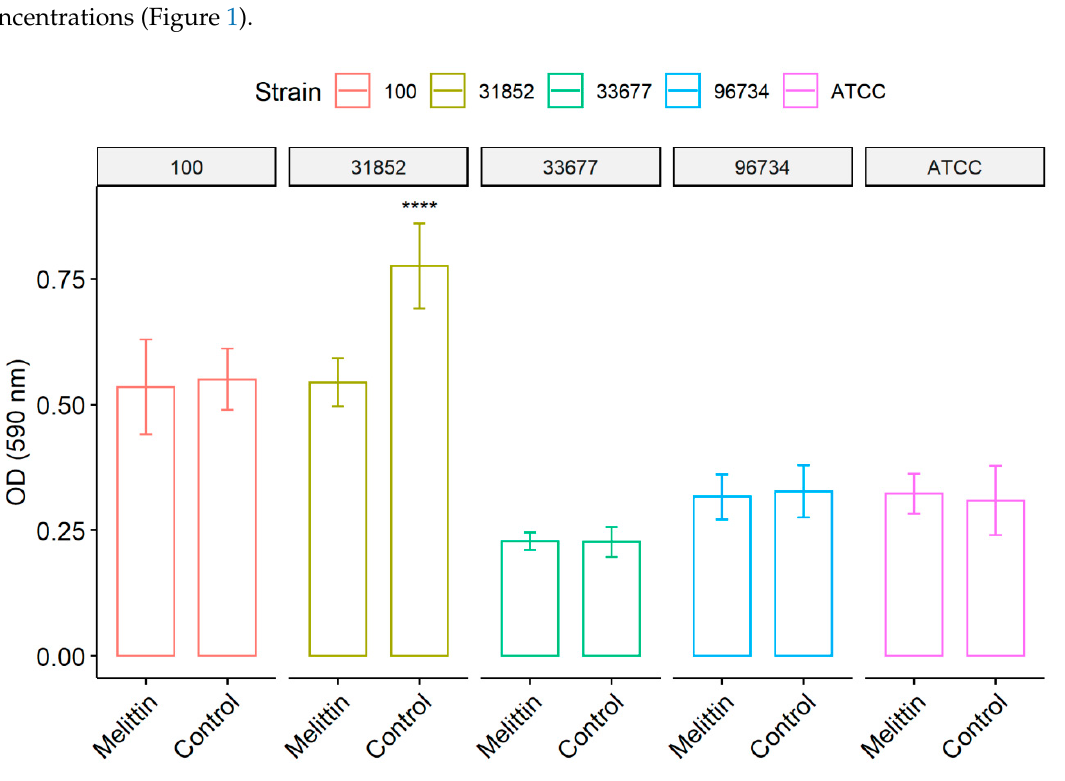
Figure 1. The action of melittin on biofilms of A. baumannii strains. Bacteria were allowed to grow in 96-well plates; after 24 h, the biofilms were treated with melittin (142 µg/mL) and after 2 h the biofilms were quantified by staining with crystal violet. Control represents untreated groups. Results represent the mean and standard deviation of at least three independent experiments. **** Statistically significant ( p < 0.001) using t- test.